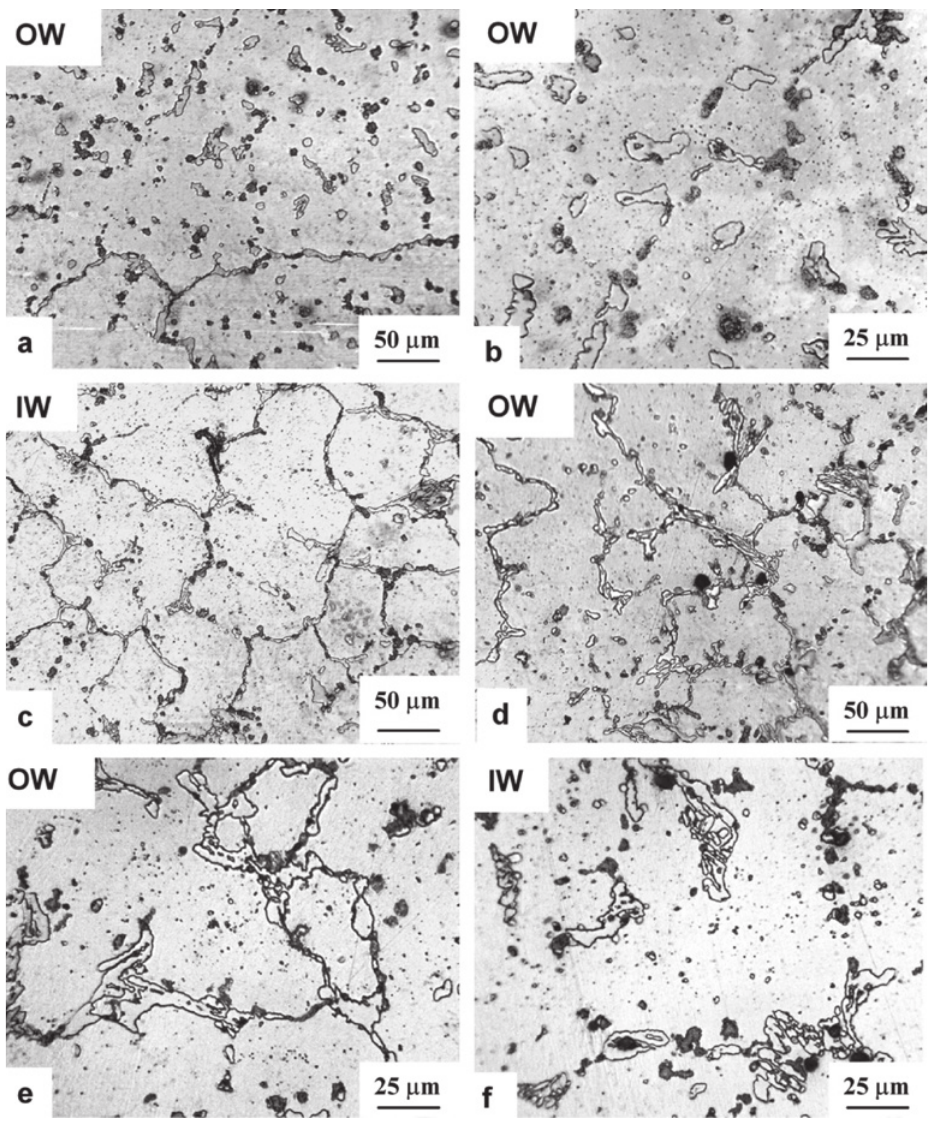
Fig. 12: Photomicrographs of transverse sections of etched specimens from unfailed tube portions: (a–c) CD123-2; (d–f) AB49-2. No microcracks and creep cavities were observed. IW, near inner wall; OW, near outer wall region